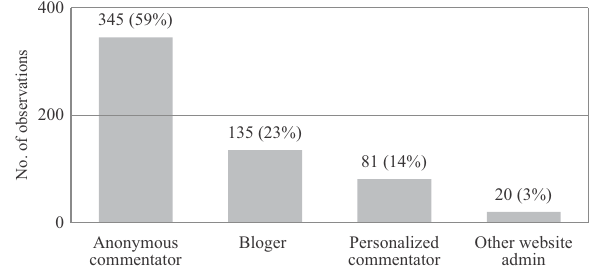
Fig. 2. Entities commenting the entries in the analysed recreational blogs Source : Own